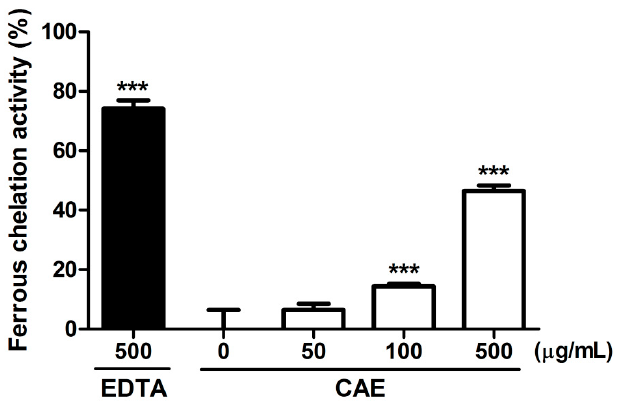
Figure 2. Ferrous ion chelating activity of CAE. EDTA (500 µ g/mL) was applied as the positive control. A significant difference between this activity and that of the untreated (0 µ g/mL CAE) group could be observed. Significant difference versus control in each experiment: ***, p < 0.001.